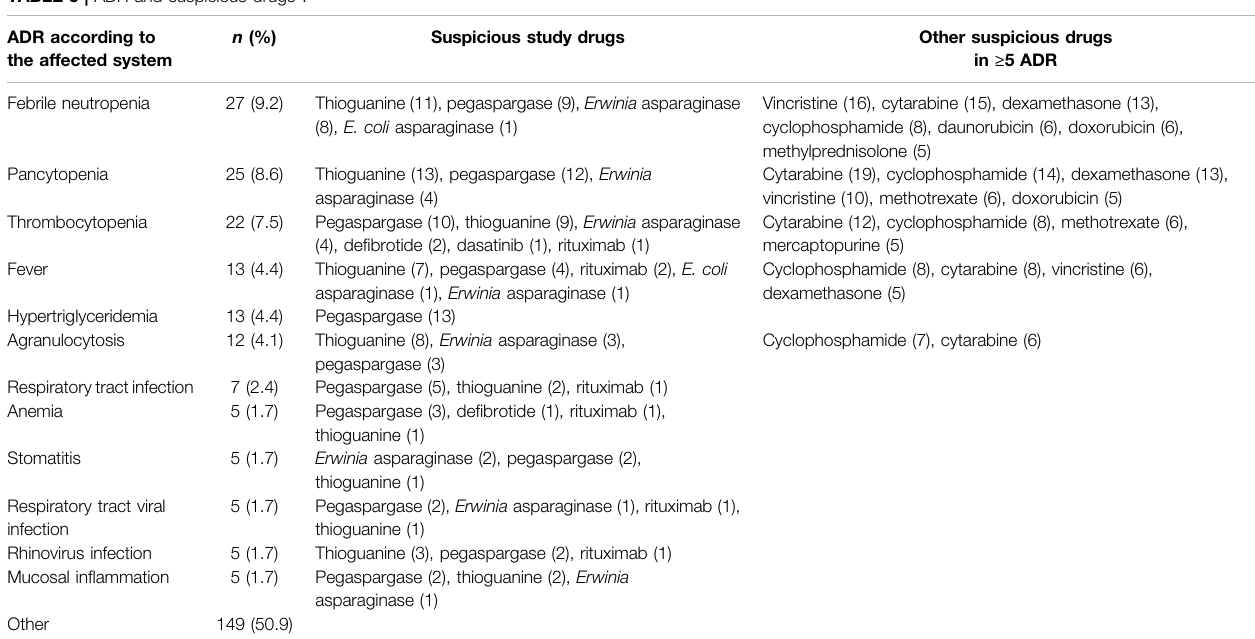
TABLE 5 | ADR and suspicious drugs a .